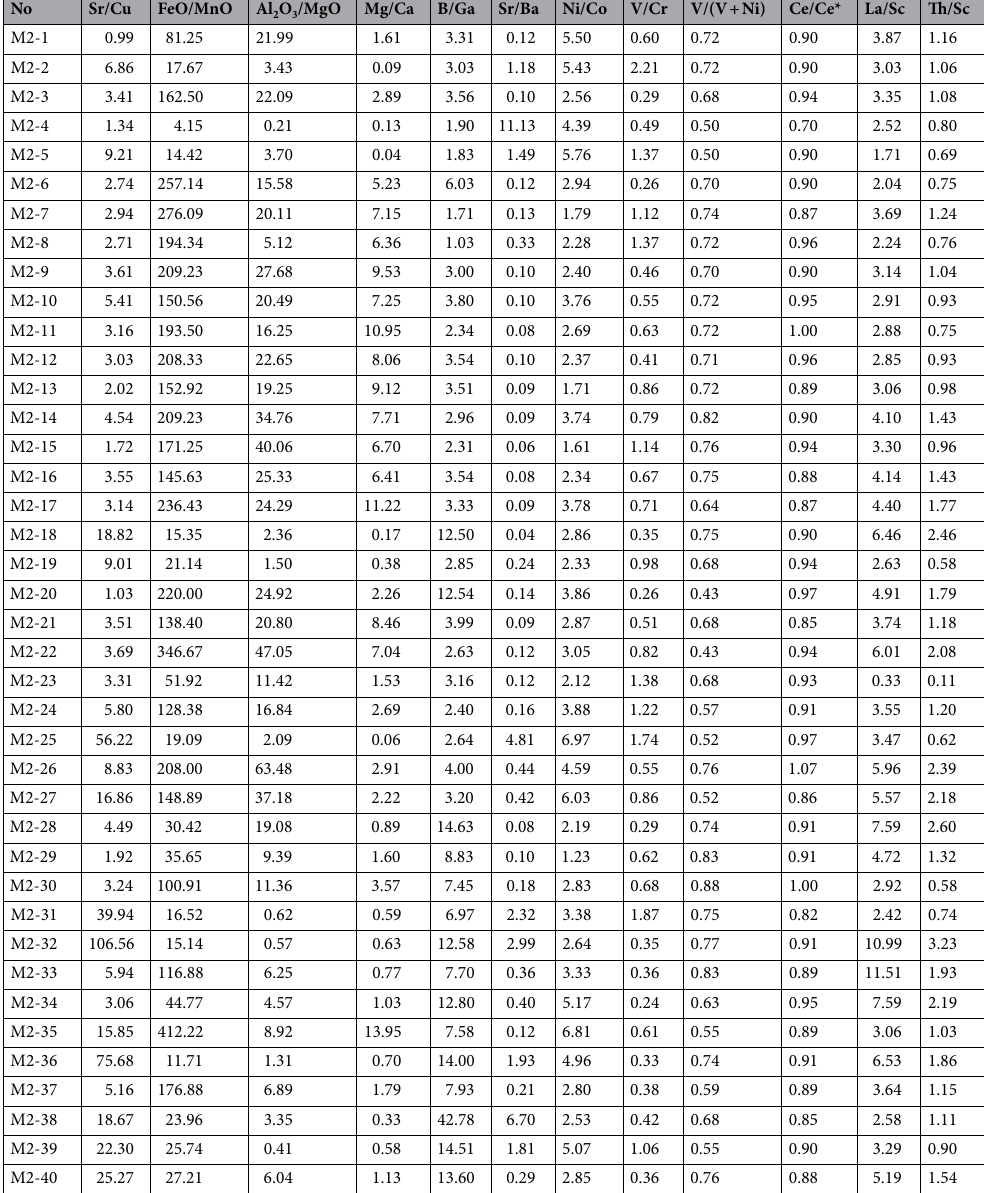
Table 5. Selected element ratios from Well M2, Jitai